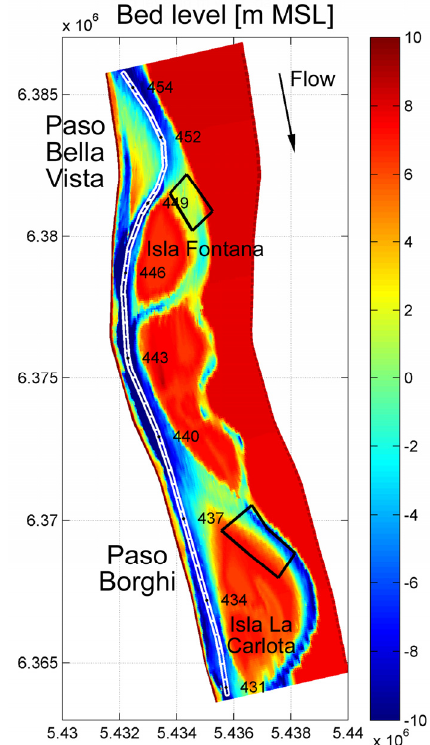
Figure 3. Initial bed level in m above mean sea level (MSL). The white lines indicate the navigation channel, subdivided in 500 m long sections. The black “polygons” indicate dump sites “Bella Vista” and “Borghi”.